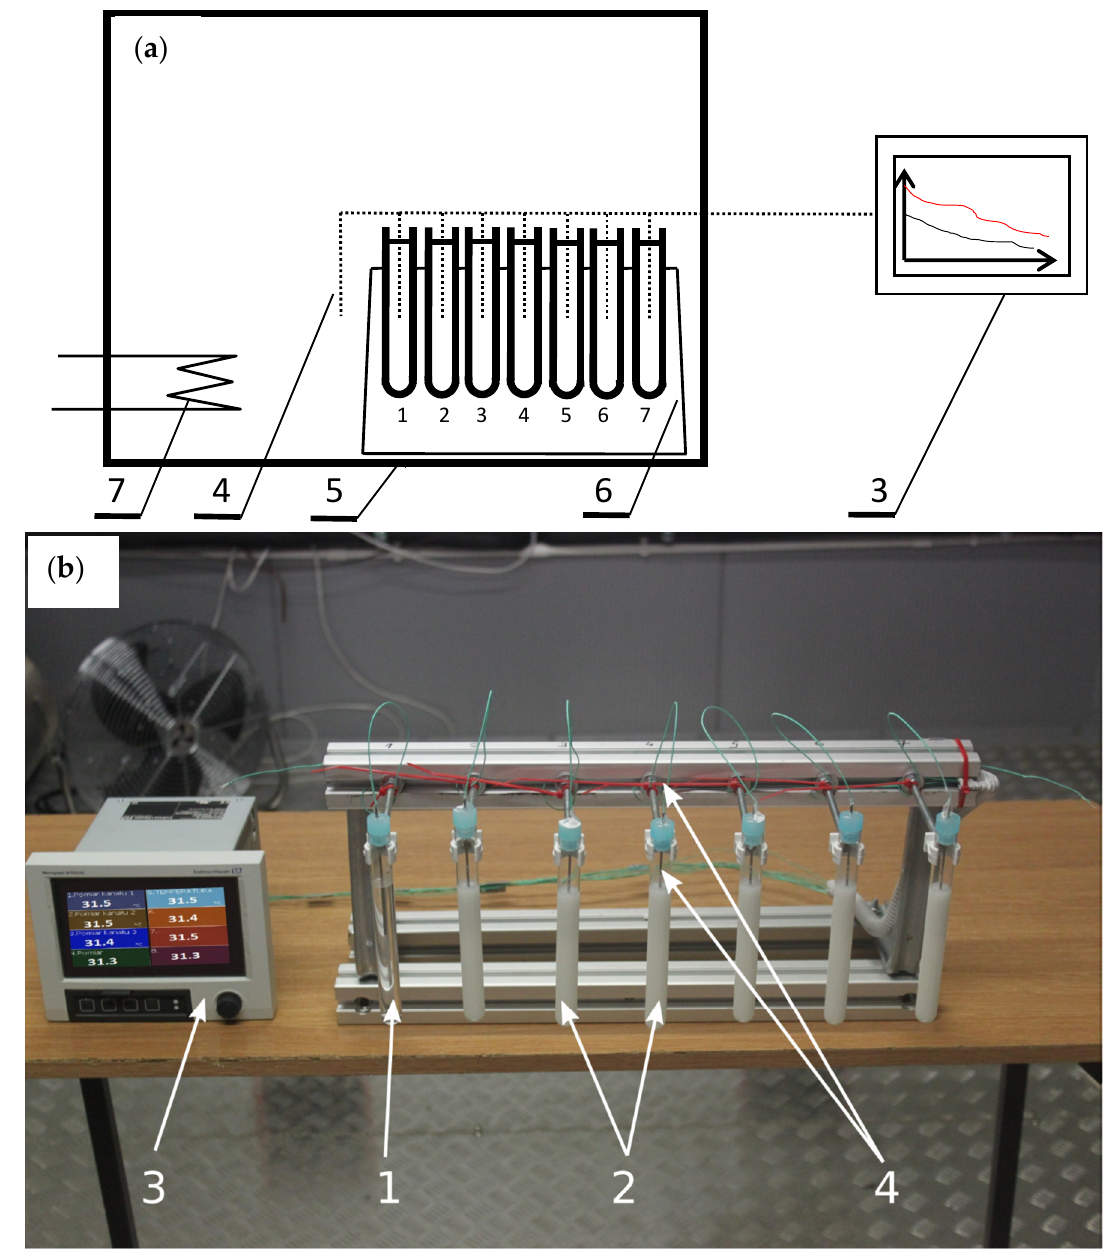
Figure 1. Schematic of the test bench and ( a ) overview of the measuring section inside the temperature-controlled chamber ( b ); 1—sample with reference liquid (distilled water), 2—test samples with different concentration of suspension, 3—data acquisition module, 4—K-type thermocouple array, 5—test chamber/room, 6—sample support structure, 7—electric heater with power regulation.